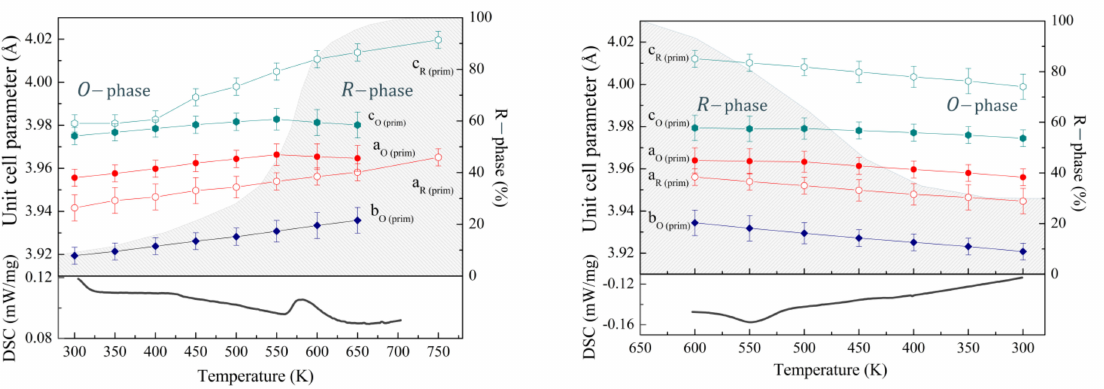
Figure 2. The unit cell parameters of the O - and R- phases at different temperaturs based on the SPD and NPD data on heating ( left ) and cooling ( right ) cycles; the estimated volume ratio of the phases is denoted by the dashed areas; the DSC curves are depicted at the bottom of the